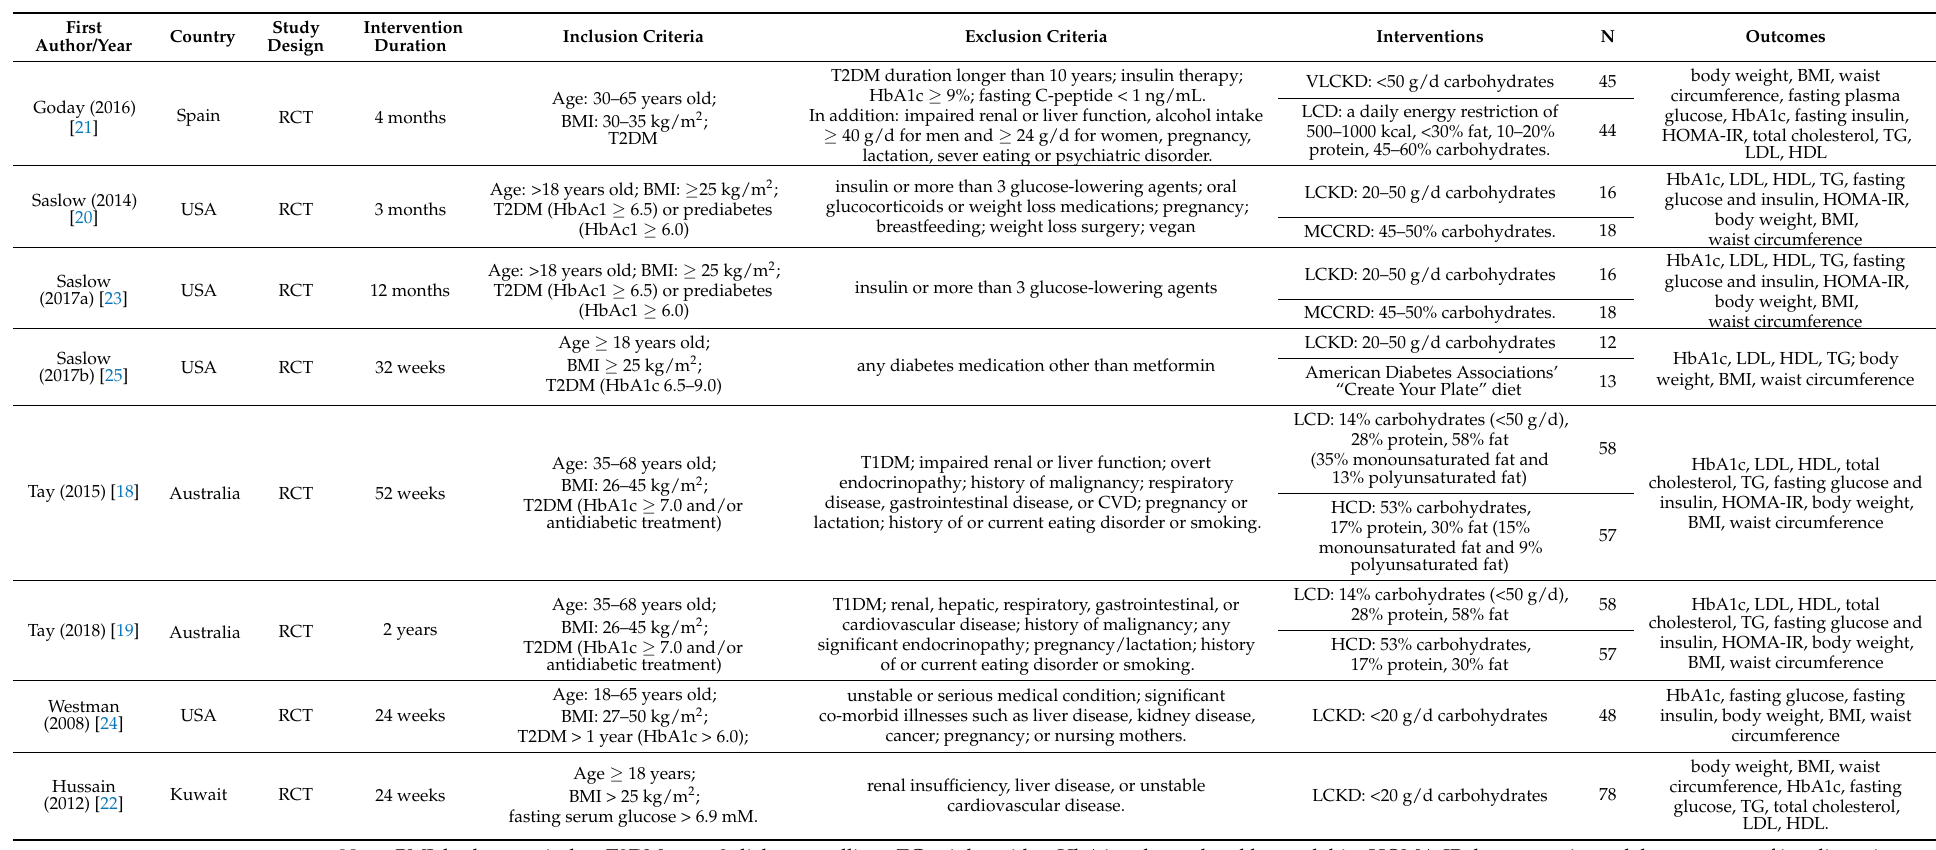
Table 2. Characteristics of included